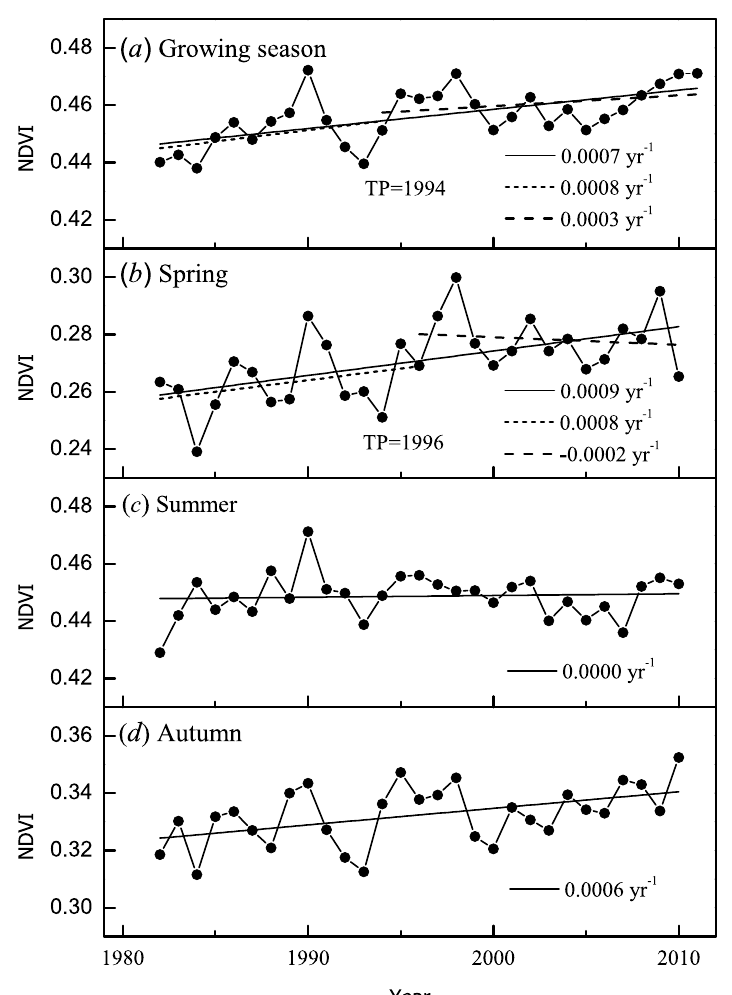
Figure 5. Interannual variation of NDVI in ( a ) growing season; ( b ) spring; ( c ) summer and ( d ) autumn over the period of 1982–2011 in China. Solid lines are trend lines over the past 30 years and dash lines are trend lines before and after abrupt change point